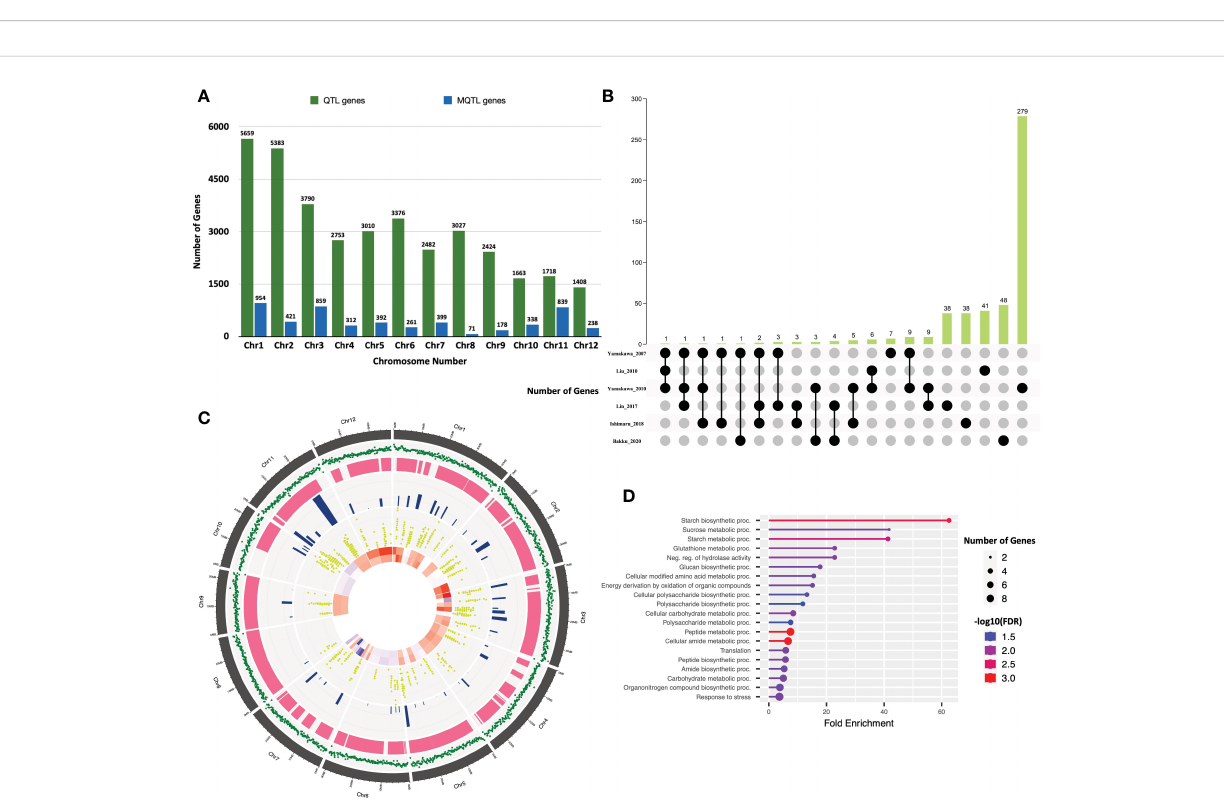
FIGURE 3 Candidate genes underlying the meta-QTL regions. (A) Chromosome-wise distribution of genes underlying QTLs and the identi fi ed meta-QTLs in rice. (B) Upset plot highlighting the number of differentially regulated genes identi fi ed in six rice grain chalk-related transcriptomic studies. (C) Distribution pattern of the gene density, QTLs, meta-QTLs, meta-QTL spanning genes and candidate genes identi fi ed on the rice genome. The outermost circle represents the chromosomes position on the rice genome in Mb. The second circle with green color outlines the gene density on the rice genome. The third and fourth inner circles display the number of initial chalk QTLs and identi fi ed meta-QTLs, respectively. The fi fth circle represents the MQTL underlying genes., while the innermost circle represents heatmap of the identi fi ed candidate genes (red represents upregulation, while blue signi fi es downregulation). (D) Gene Ontology enrichment analysis of 49 candidate genes representing the biological process. Created using ShinyCircos Yu et al.,